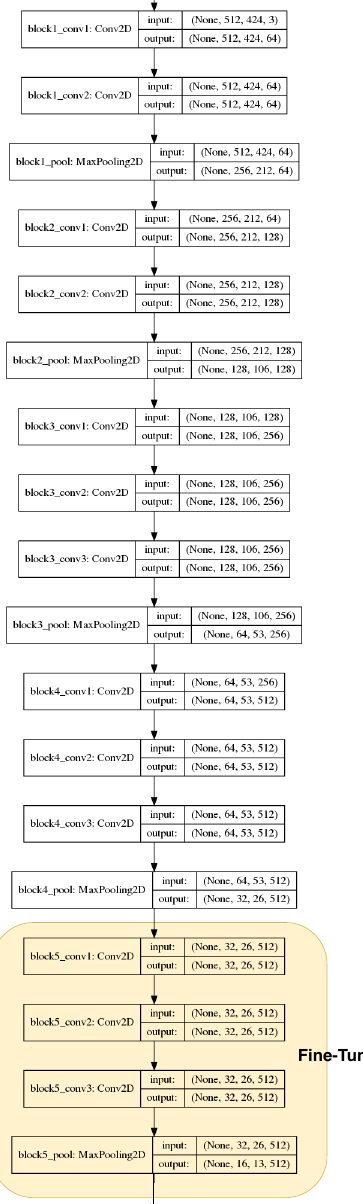
Figure 5. Transfer learning/Fine-Tuning: Convolutional Base of VGG16 model where layers selected to re-train are highlighted in yellow. Keras support to graph models [29] was